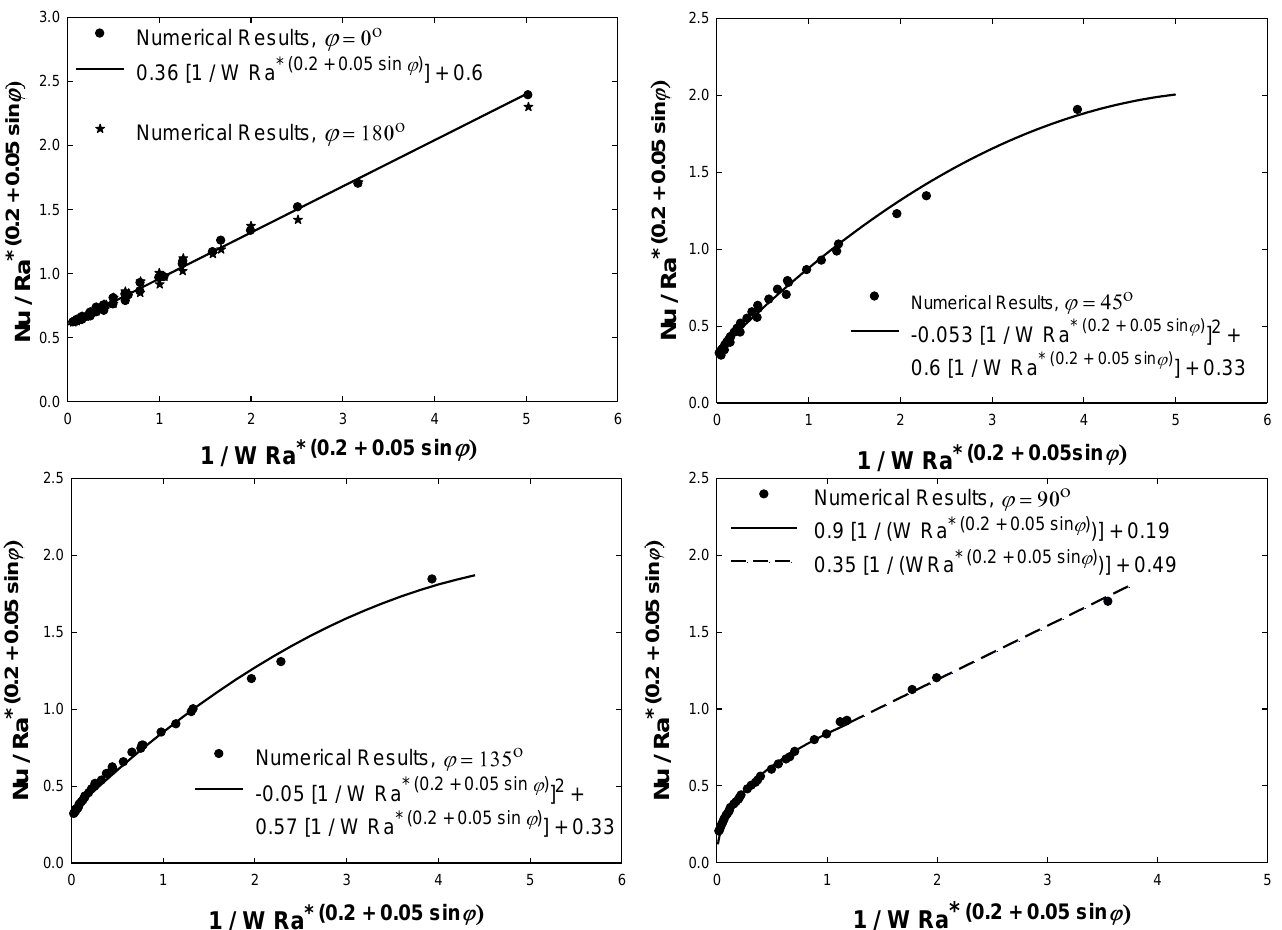
Figure 21. Comparison between present correlation equation and numerical results for different inclination angles, heat flux Rayleigh numbers, and dimensionless widths used in the present study .